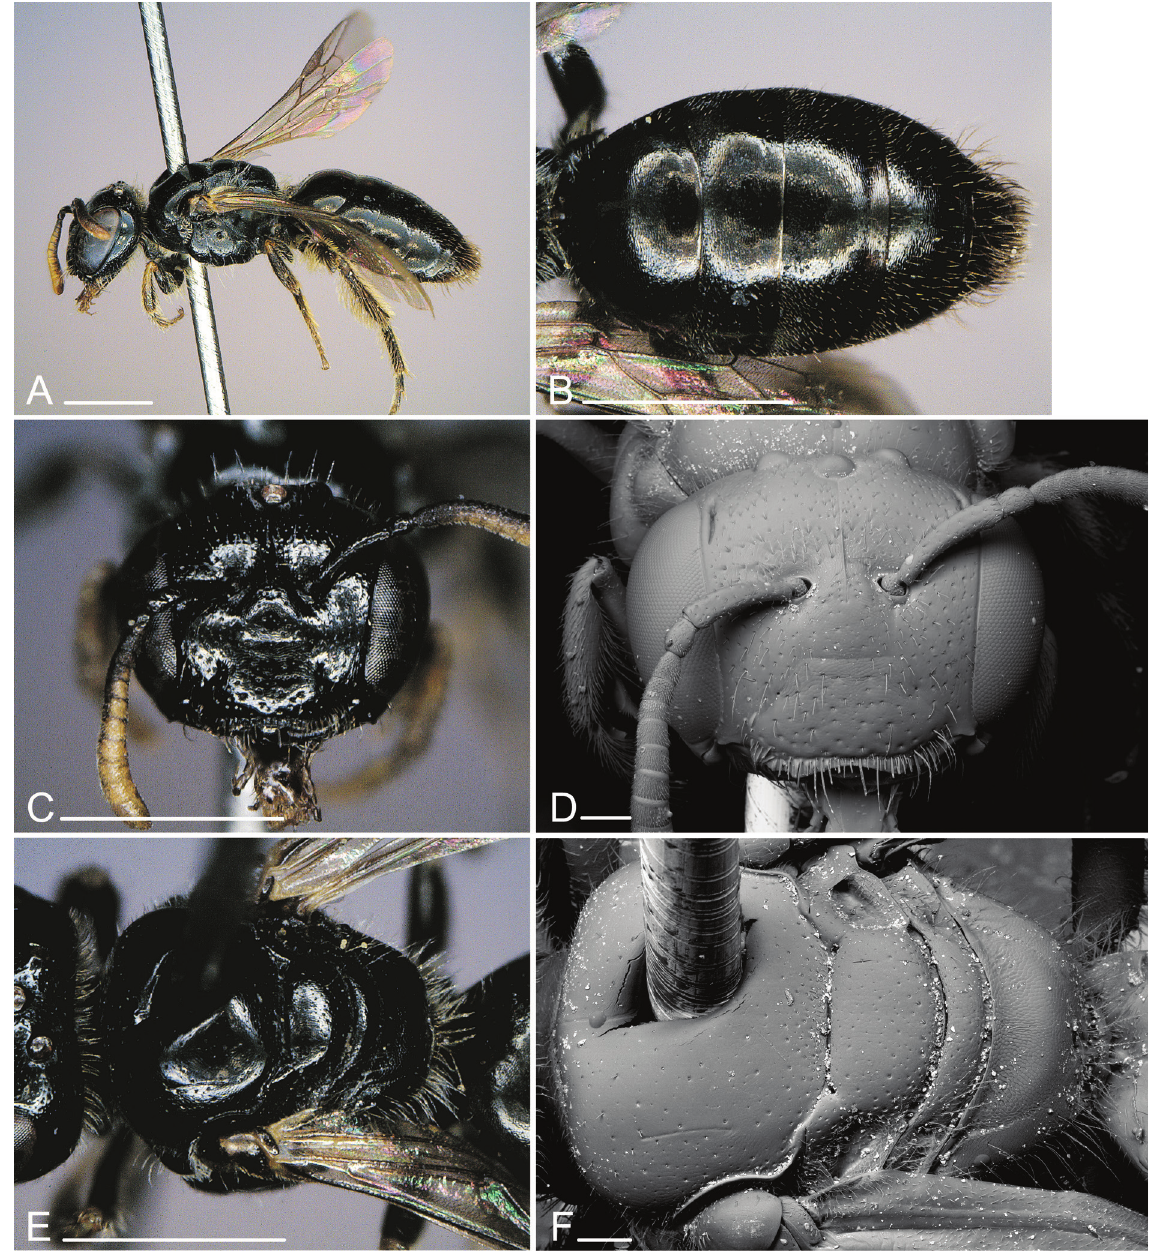
Fig. 6. Scrapter exiguus sp. nov., ♀. A . Lateral view. B . Metasoma (dorsal view). C . Head. D . Head (SEM). E . Thorax (dorsal view). F . Thorax (dorsal view, SEM). Scale bars: photos: 1 mm, SEM: 0.1